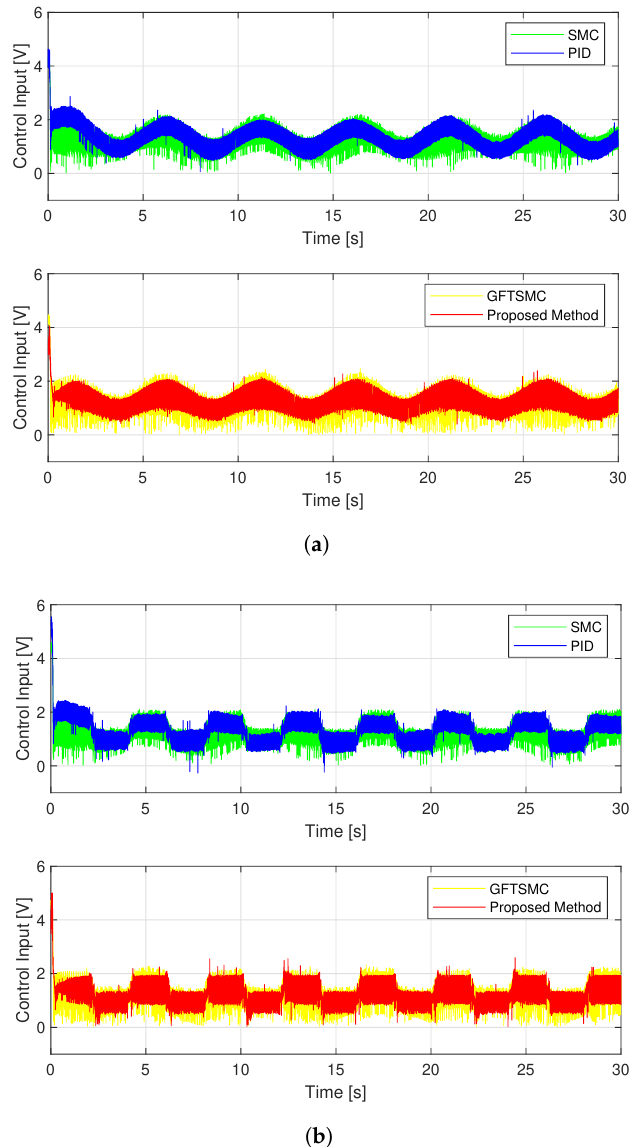
Figure 13. Control voltage of four controllers; ( a ) in case of sinusoidal orbit; ( b ) in case of a rest-to-rest